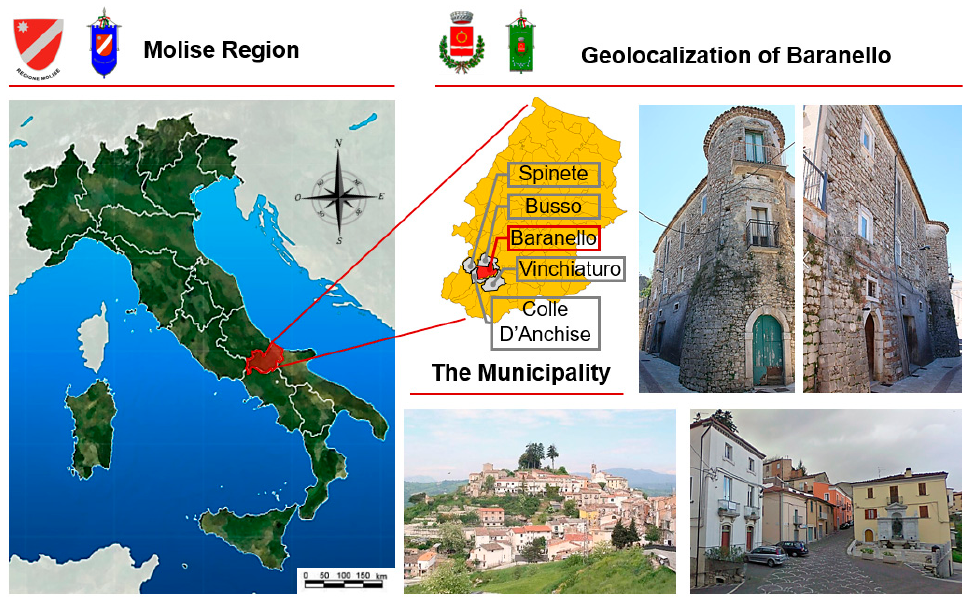
Figure 1. The geographical localization of the municipality of Baranello.